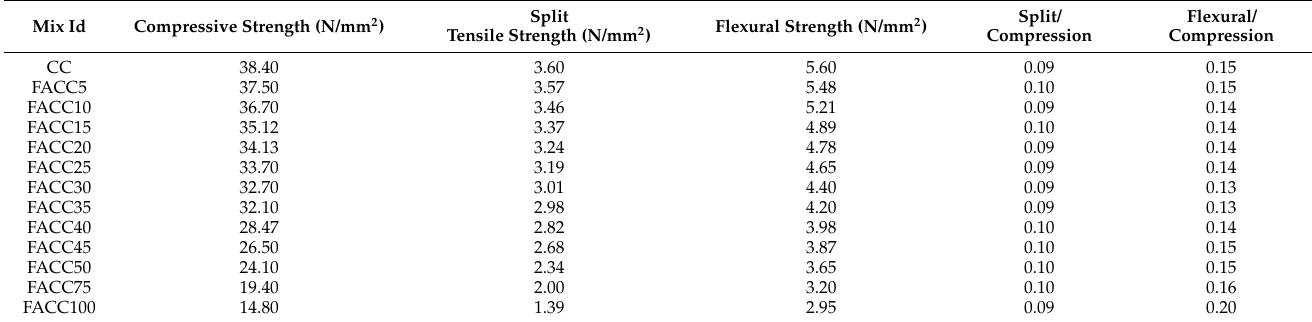
Table 5. Ratio of Split and Flexural Strength Value to Compression Strength Value.